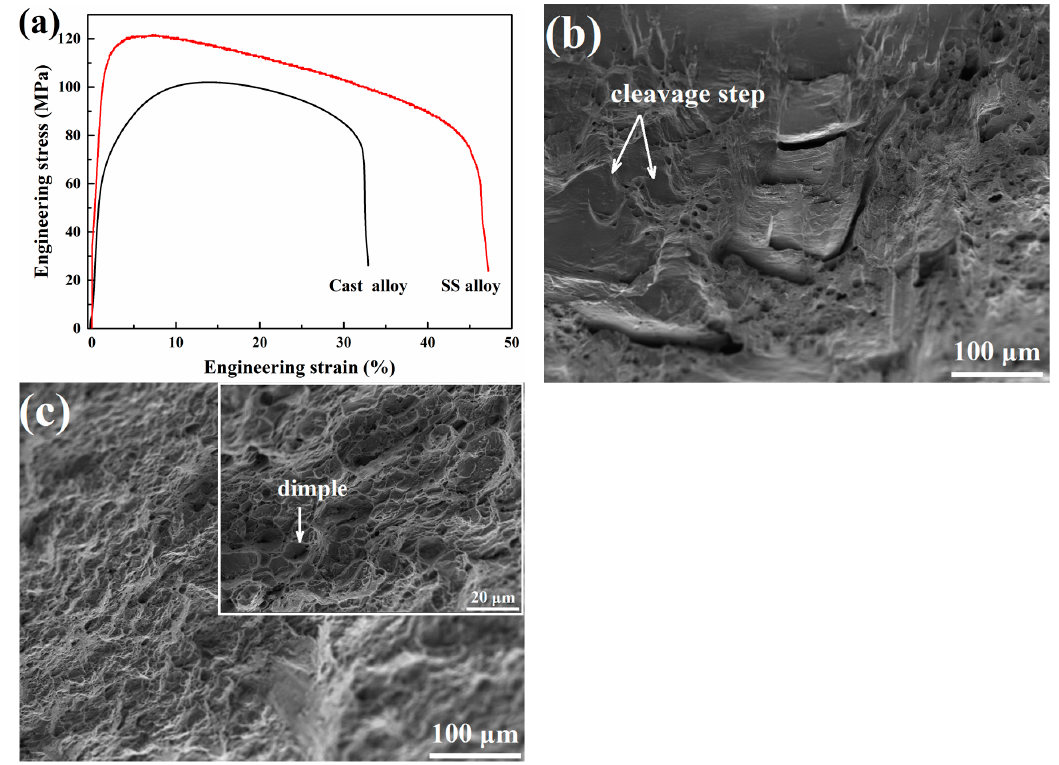
Figure 4. Engineering tensile strain-stress curves of Mg-9Li alloys ( a ) and SEM fracture morphologies of the cast alloy ( b ) and SS alloy ( c ).